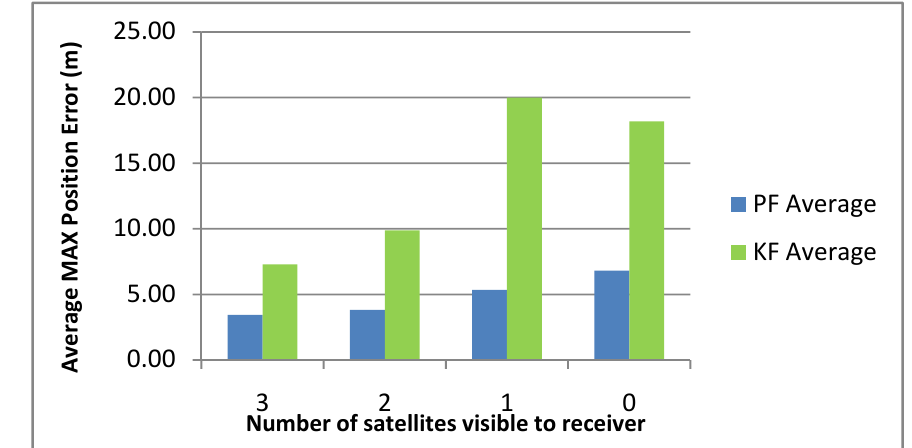
Figure 12. Average RMS position error over the 10 outages in Toronto-Kingston